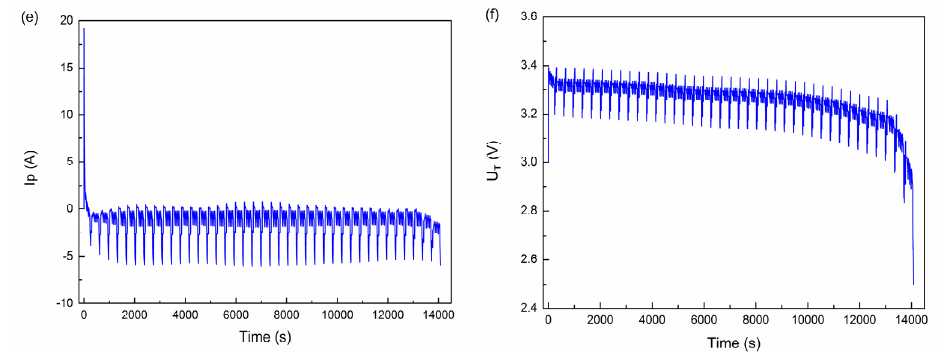
Figure 7. Online parameter and state estimation results for the DST test at 40 °C: ( a ) OCV; ( b ) R O ; ( c ) R P ; ( d ) C P ; ( e ) I P ; and ( f ) U T .